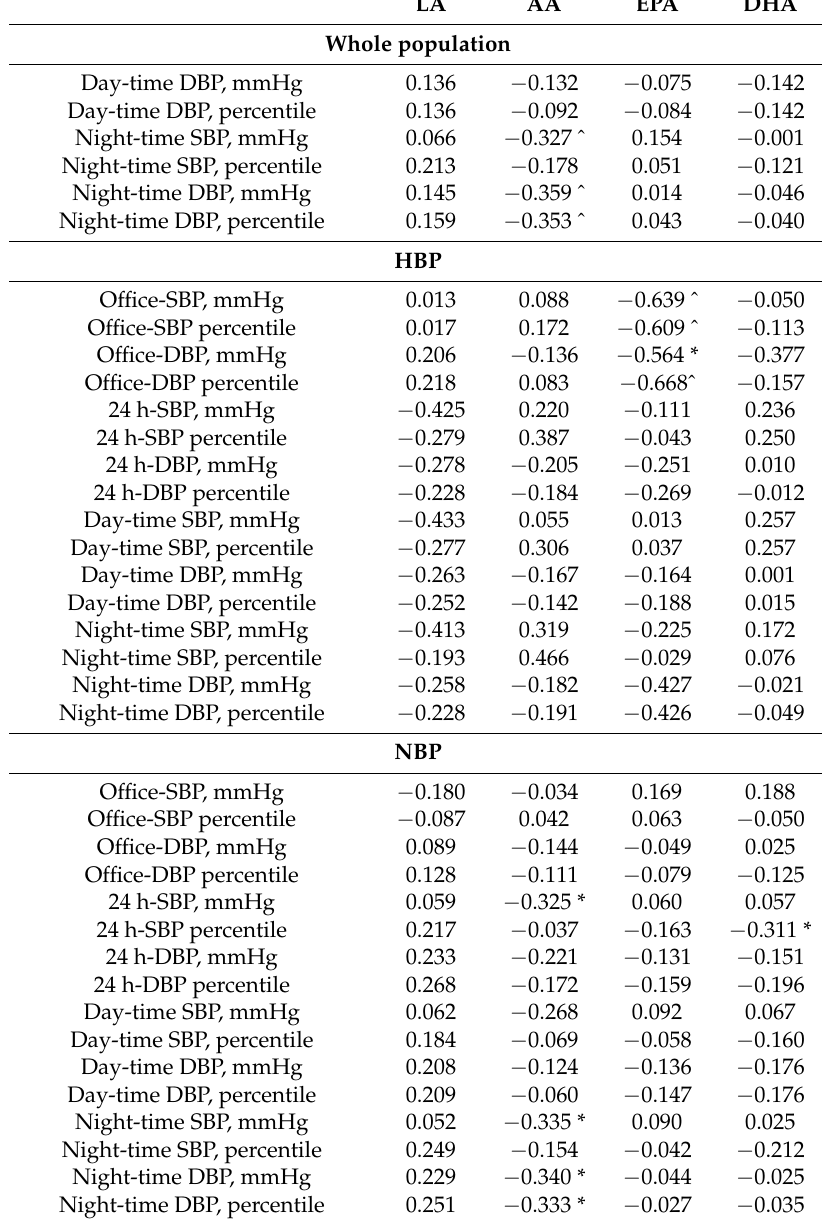
The table shows the spearman coefficients of correlations (r s ) between fatty acids (precursors), namely LA, AA, EPA, DHA and office and ambulatory BP in the whole sample and in the subgroups of HBP and NBP children. The underlined correlations remained significant after adjustment for sex, age, pubertal status and BMI. *: p < 0.05; ˆ: p < 0.01 after False Discovery Rate correction. NBP: normal blood pressure; HBP high blood